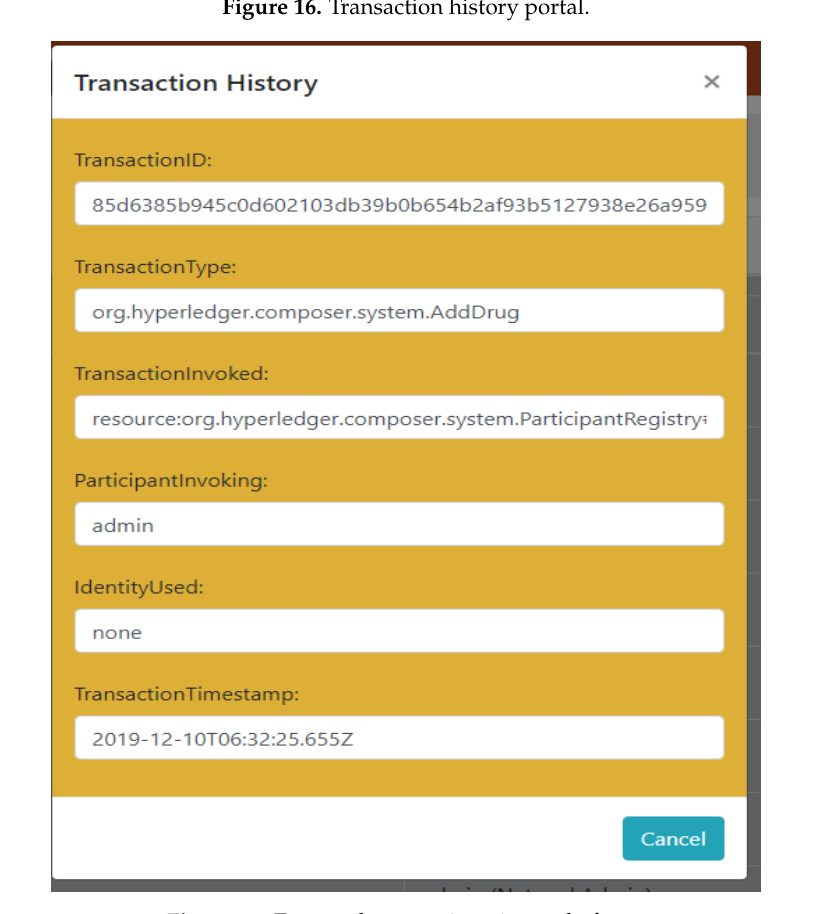
Figure 17. Executed transaction view only